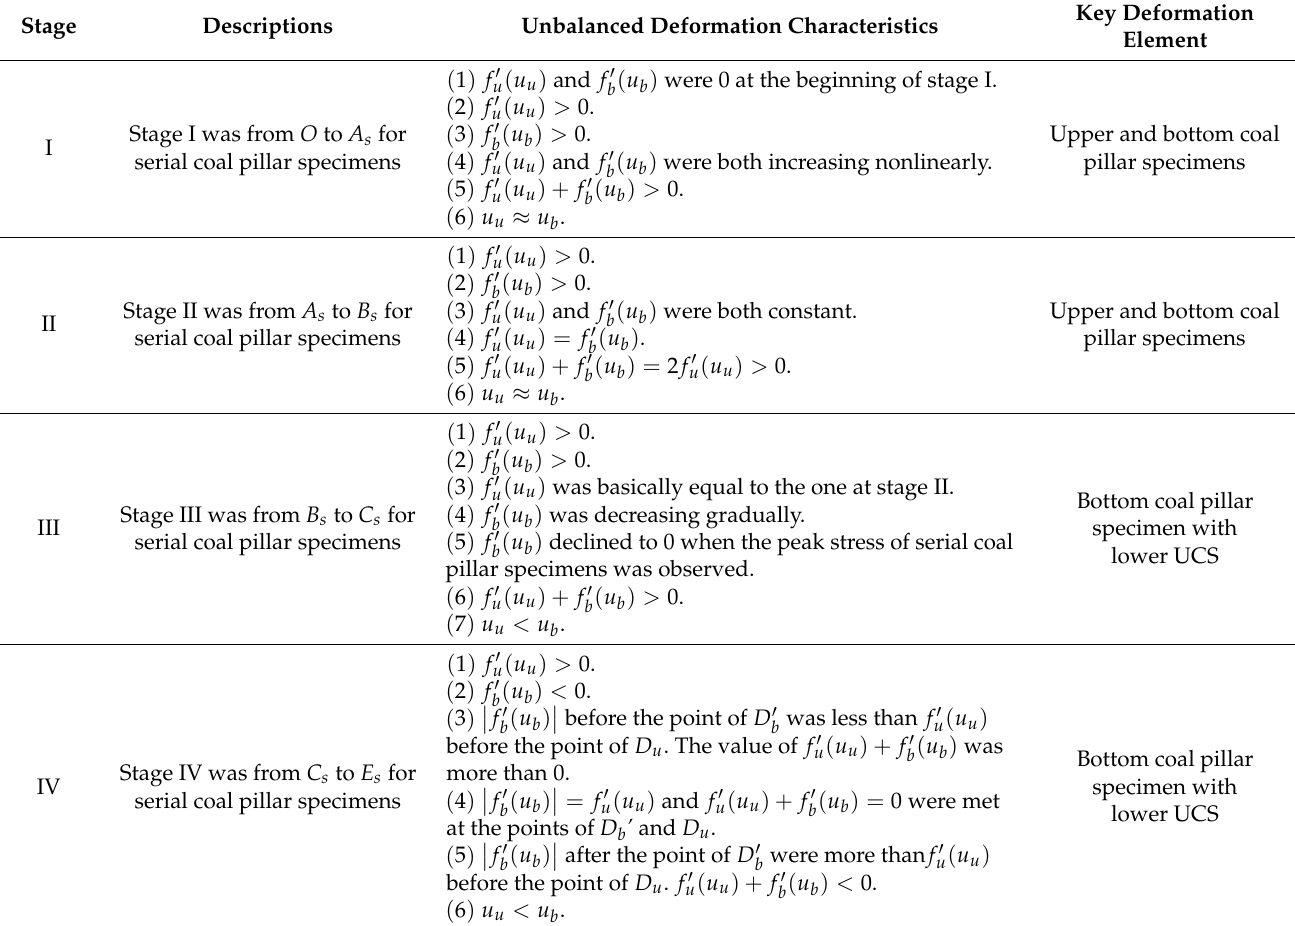
Table 5. Progressive fracturing evolution of serial coal pillar specimens (different